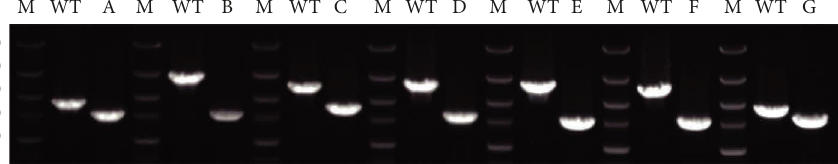
Figure 1: Te verifcation of OMP deletion mutants was performed using primers of (gene)-U-F and (gene)-D-R by DNA agarose gel electrophoresis. M marker; WT, wild type, representing ATCC33846; lanes A-H showed Δ VP_RS22195 , Δ VP_RS23020 , Δ VP_RS16800